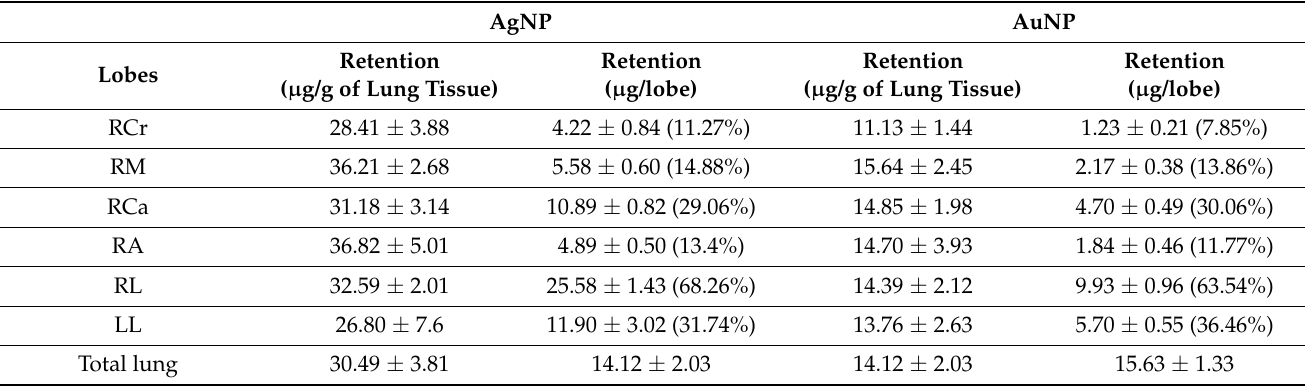
Table 3. Lung deposition of 5-day subacute inhalation exposure for soluble silver nanoparticles